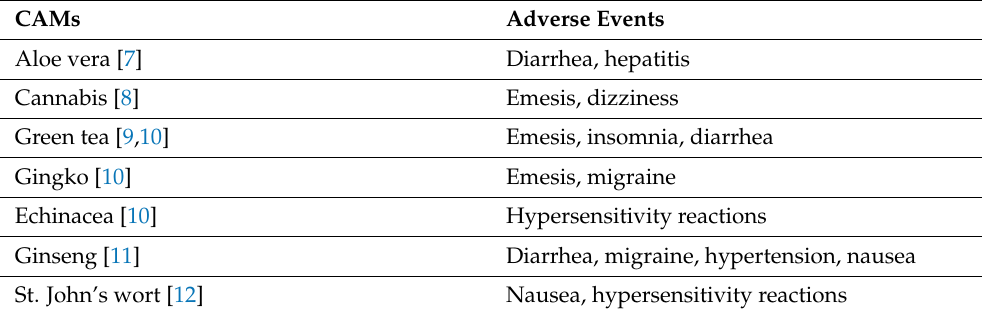
Table 2. Examples of most serious and frequent AEs caused by